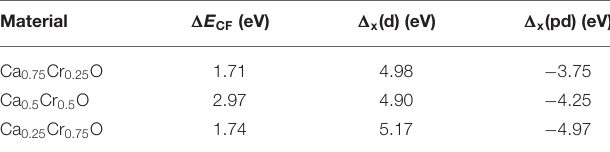
TABLE 4 | Computed energies of crystal field 1 E CF , direct 1 x ( d ), and indirect 1 x ( pd )exchange splittings for Ca 1-x Cr x O at concentrations x = 0.25, 0.5, and 0.75.